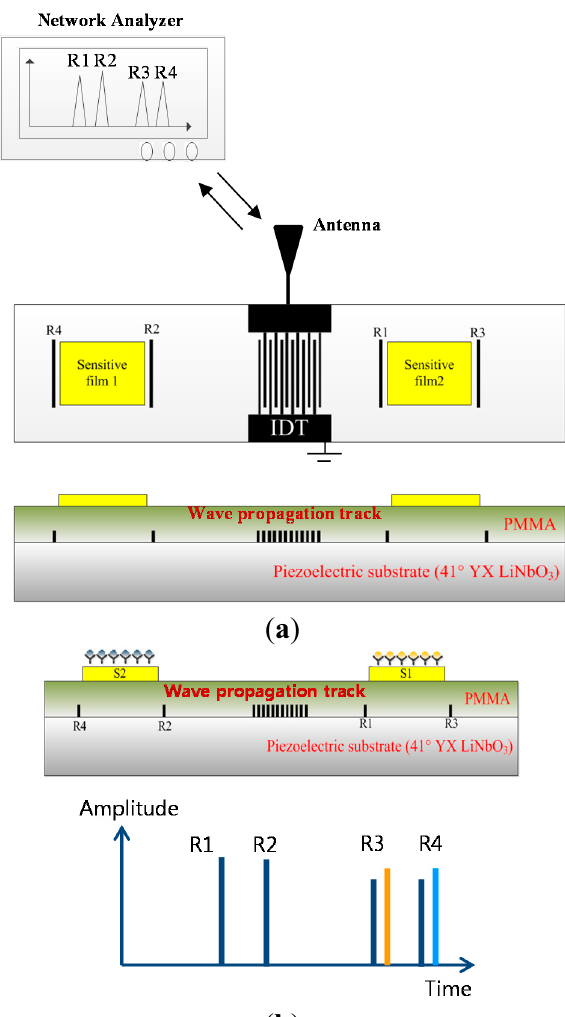
Figure 1. Schematic view of the fabricated device ( a ) from top and cross-sectional view and ( b ) expected reflection peaks derived from four reflectors and two sensitive films in terms of time when analytes are attached onto the sensitive films. Mass loading of bioanalytes onto the sensitive films induces the reflection peak shifts in R 3 and R 4